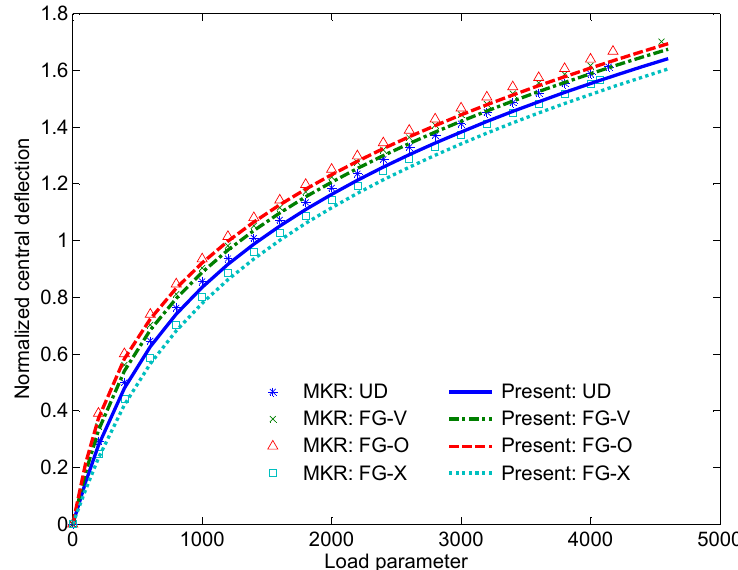
Figure 5. Normalized central deflections ˆ w of the fully clamped FG-CNTRC cylindrical panels with = 0.11, h / R = V ∗ CNT